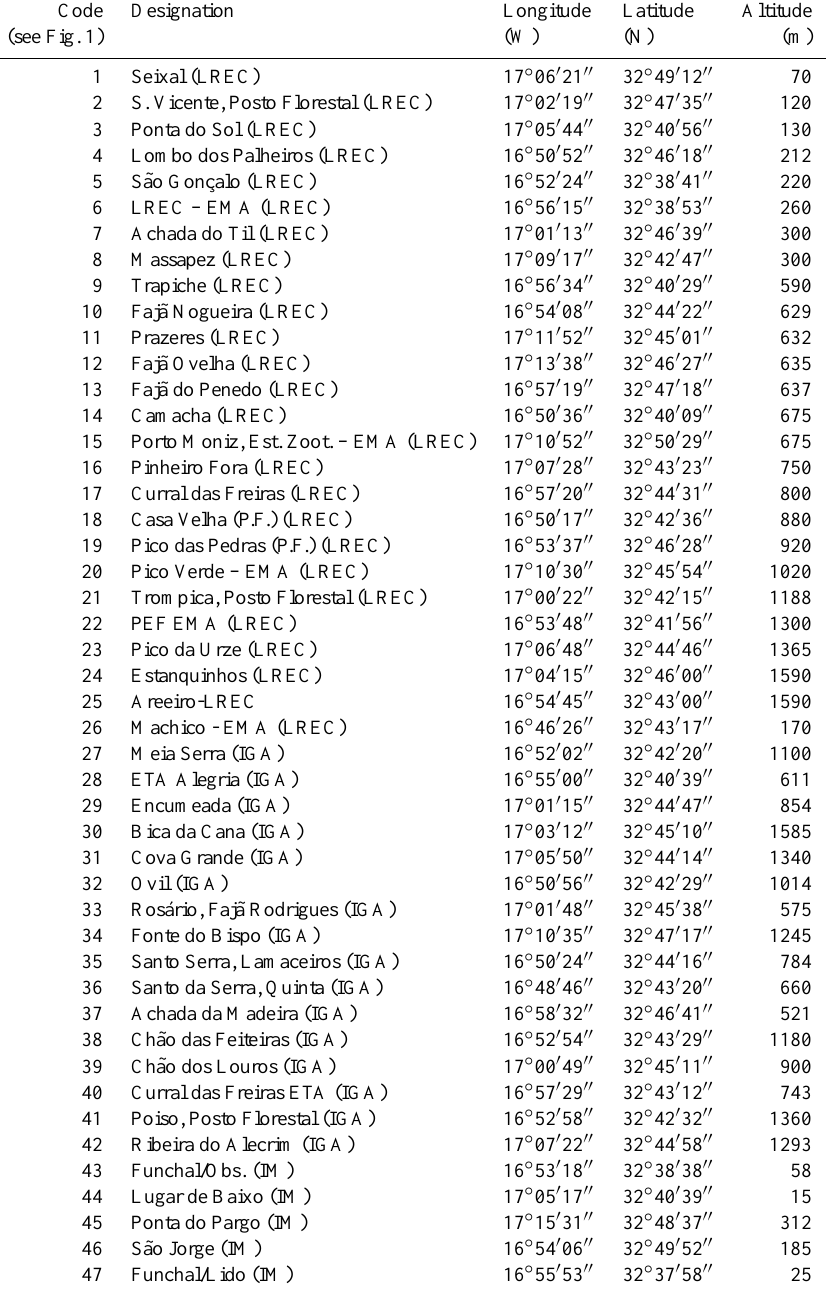
Table 2. Description of meteorological stations and raingauges used in this